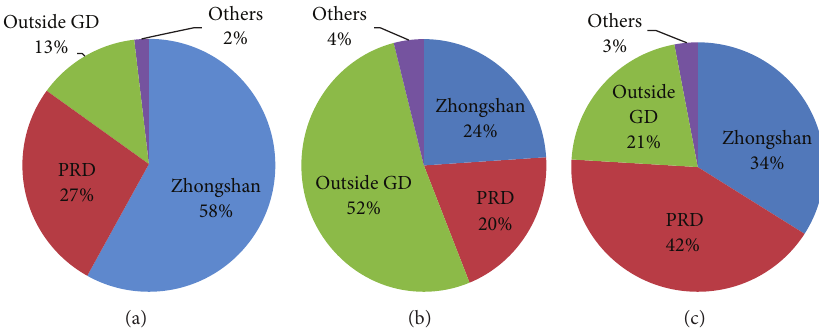
Figure 6: Percentage contributions of the emissions from different regions to the simulated PM 2.5 in Zhongshan under (a) no cold front, (b) strong cold front, and (c) weak cold front